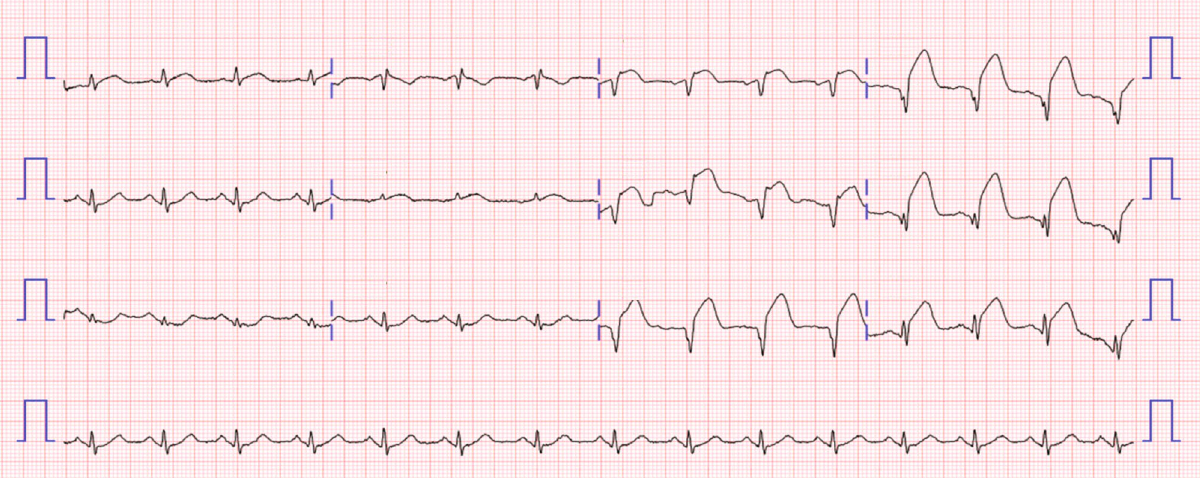
Figure 1: Initial ECG of a 58-year-old man in our hospital. This ECG reveals ST elevations in leads V III, and aVF. ECG: electrocardiogram.